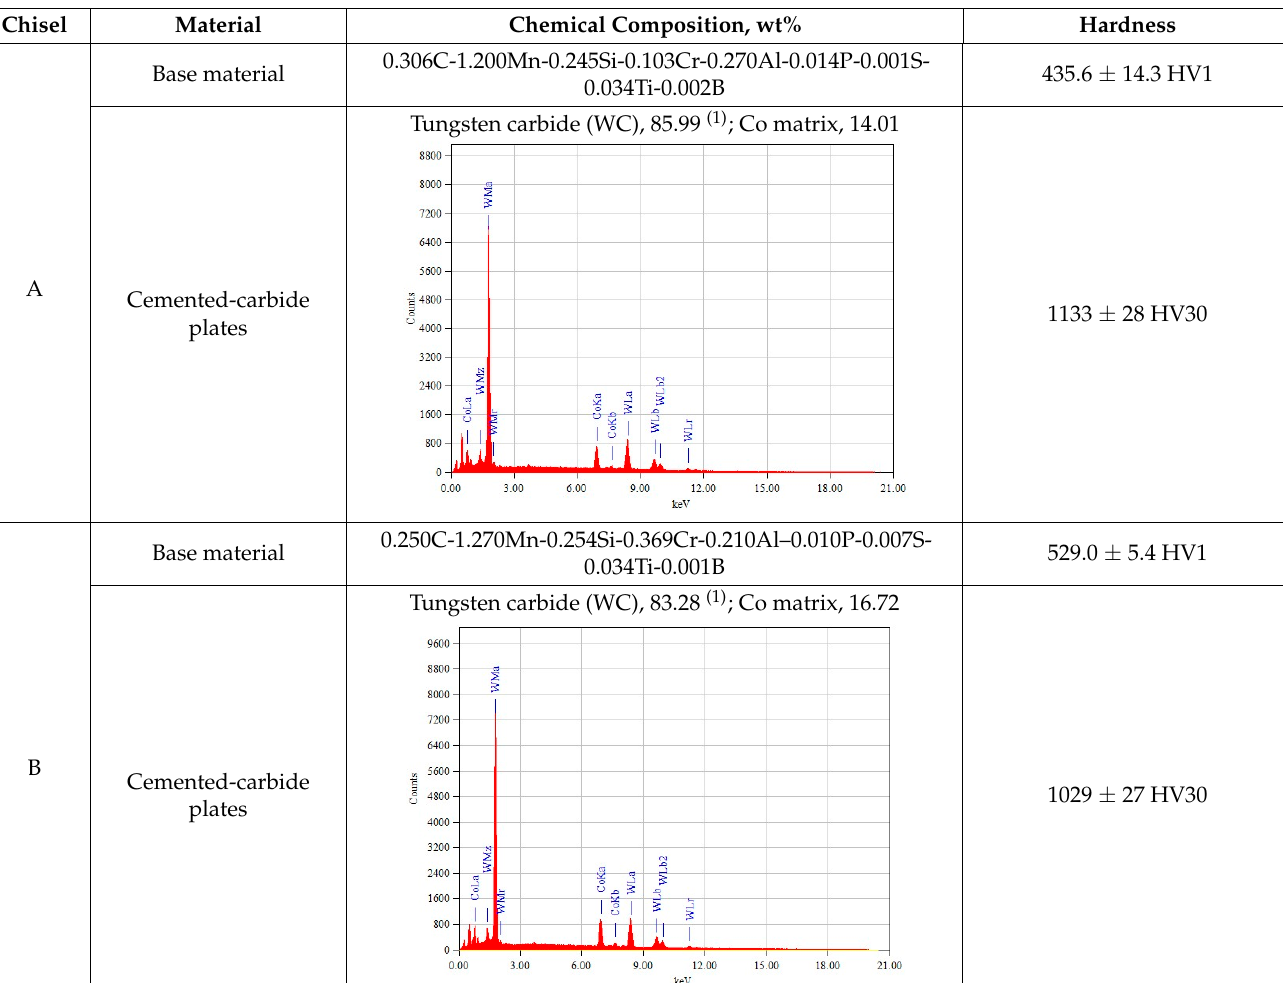
Table 3. Chemical composition and hardness of materials used in chisels.